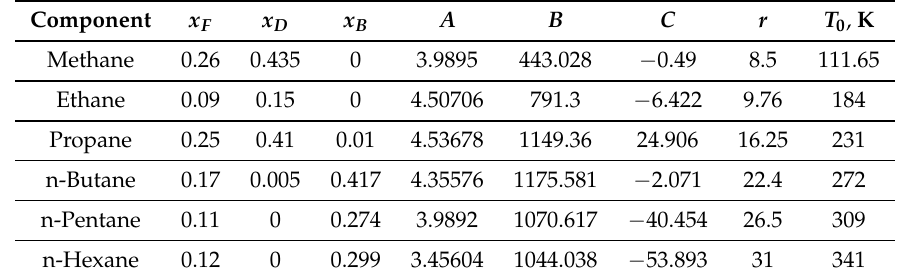
Table 2. Data for Example